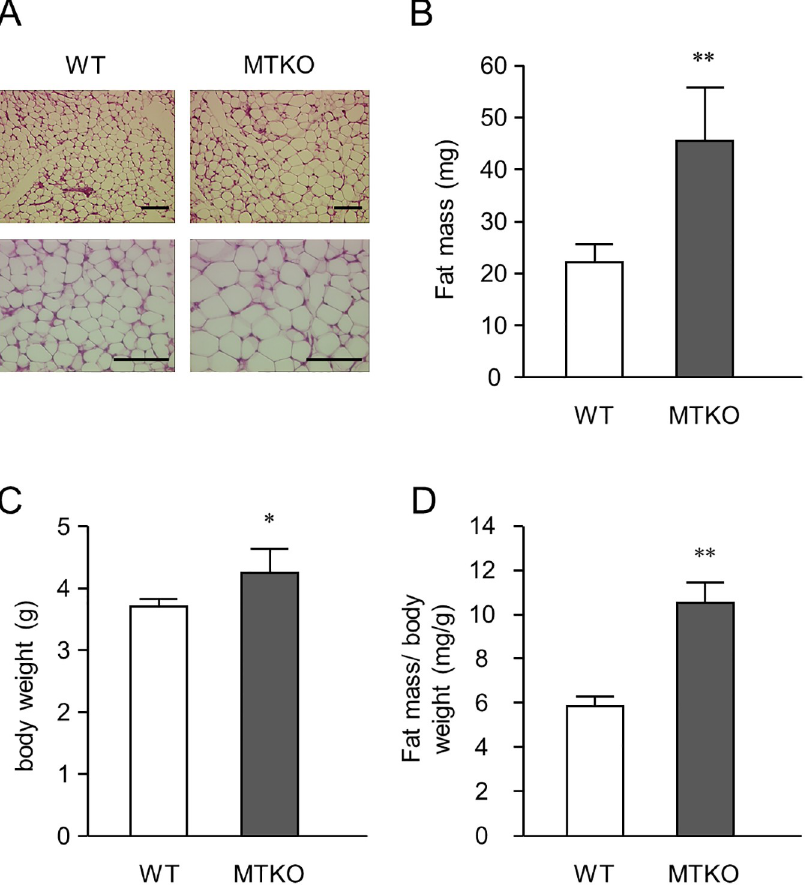
Fig 1. White adipose tissues (WATs) of five-day-old wild type (WT) and MTKO mice. Dorsal-ventral subcutaneous fat pads were excised from five-day-oldmice. (A) Representative histologyimages of WAT in five-day-old WT and MTKO mice. WATs were larger in MTKO mice than in WT mice. Bar = 100 μ m. (B) WAT weight and (C) body weight of five-day-oldWT and MTKO mice. (D) Percent WAT weight was calculatedby dividingfat mass by body weight. Values are presented as the mean ± SD ( n = 5). ** representsa P value of <